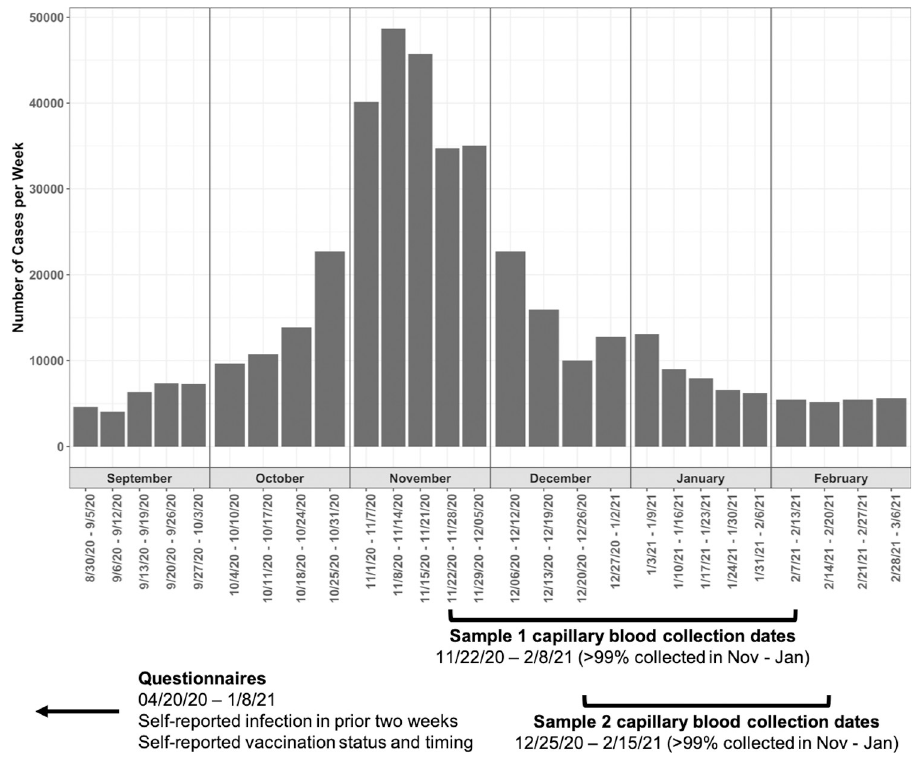
Fig 1. Study design and timeline relative to Minnesota SARS-CoV-2 infection